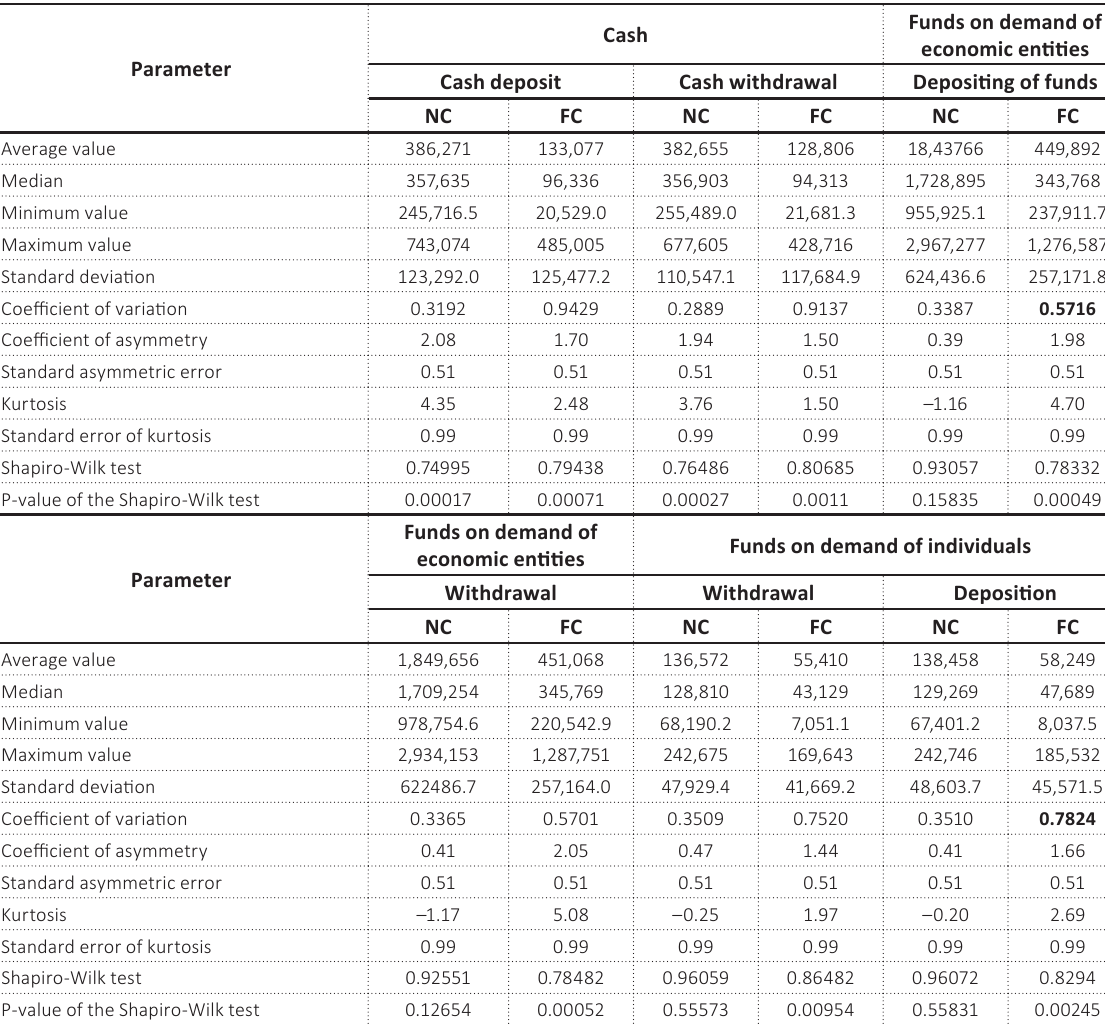
Table 2. Statistical characteristics of the dynamics of cash turnover and funds on on-demand accounts from September 1, 2017 to April 1, 2019 for JSC “JSCB